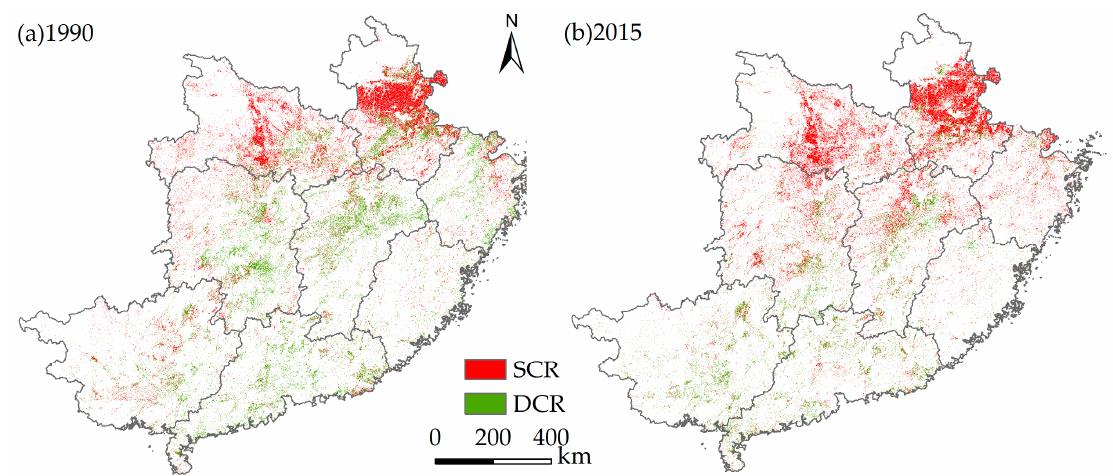
Figure 6. Resultant maps of rice cropping systems of: ( a ) 1990; ( b ) 2015. Note: DCR = double cropping rice, SCR = single cropping rice.